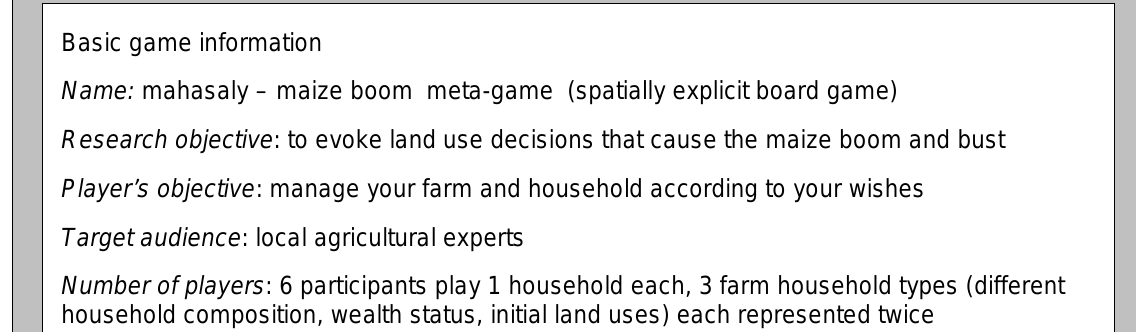
Figure A.3. Description MAHA SALY game played with Lao agricultural experts in Vientiane Capital